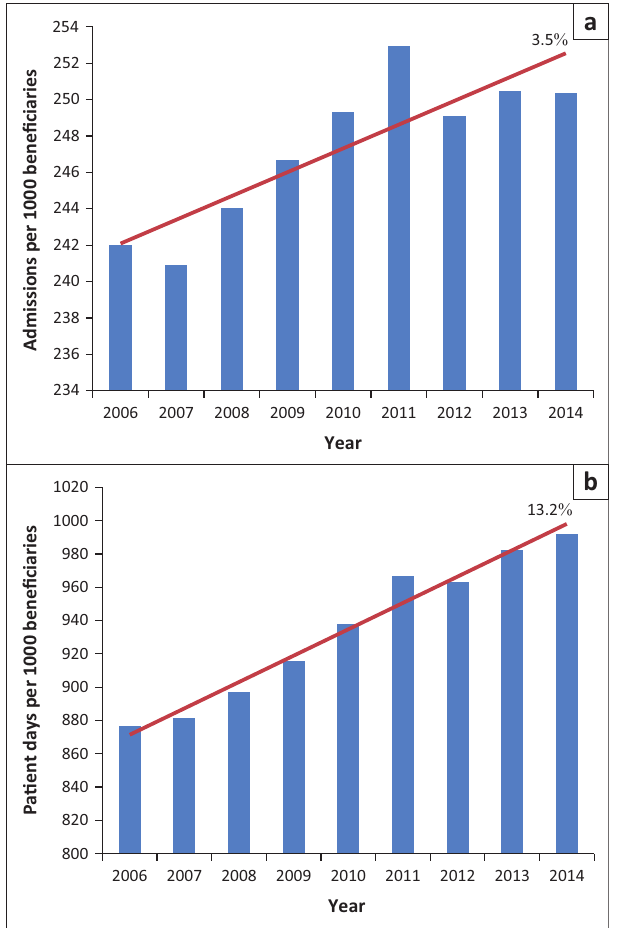
FIGURE 3: Aggregate admissions (a) and patient days (b) at three hospital groups per 1000 beneficiaries; 2006–2013.